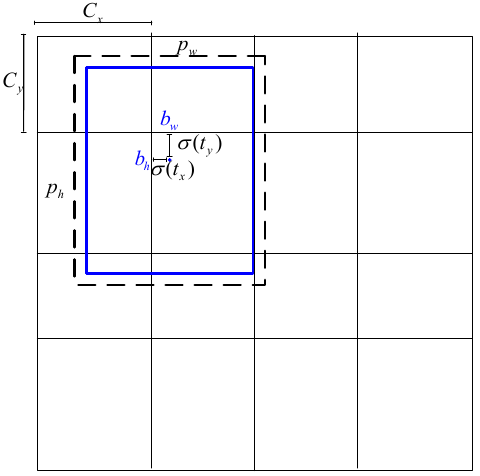
Figure 7. The prediction process for bounding boxes.